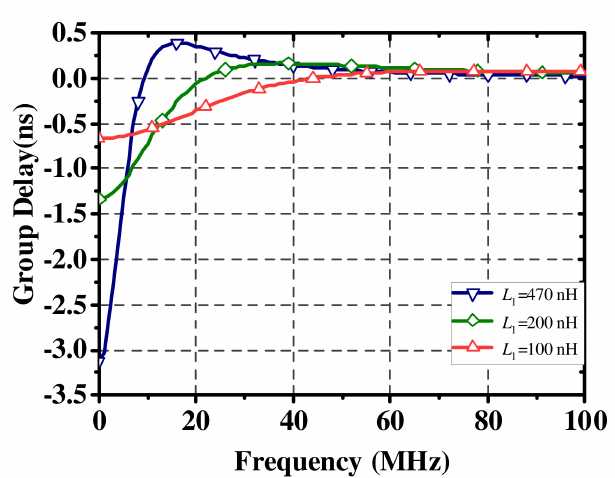
Figure 6. Group delay of low-pass negative group delay circuits with different